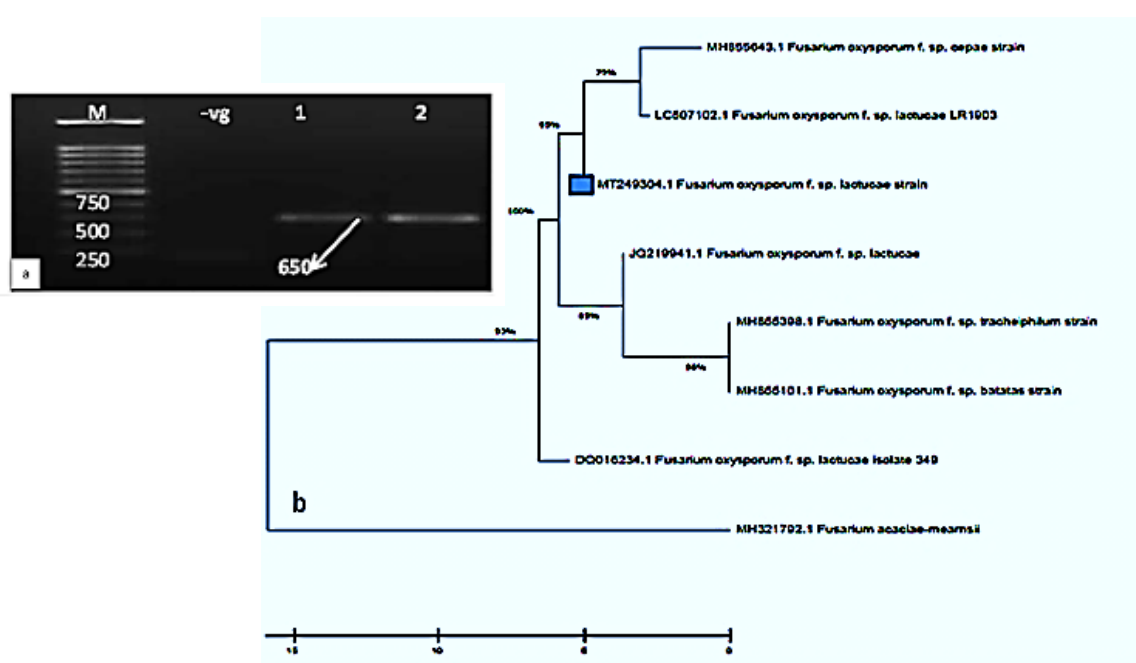
Figure 2. PCR product and phylogenetic tree of the Fusarium oxysporum f. sp. lactucae isolate. ( a ) PCR product of the isolate. M = Molecular marker, –vg = Negative control, (1–2) = F. oxysporum samples. ( b ) Phylogenetic tree based on the ITS gene sequences of the isolates.